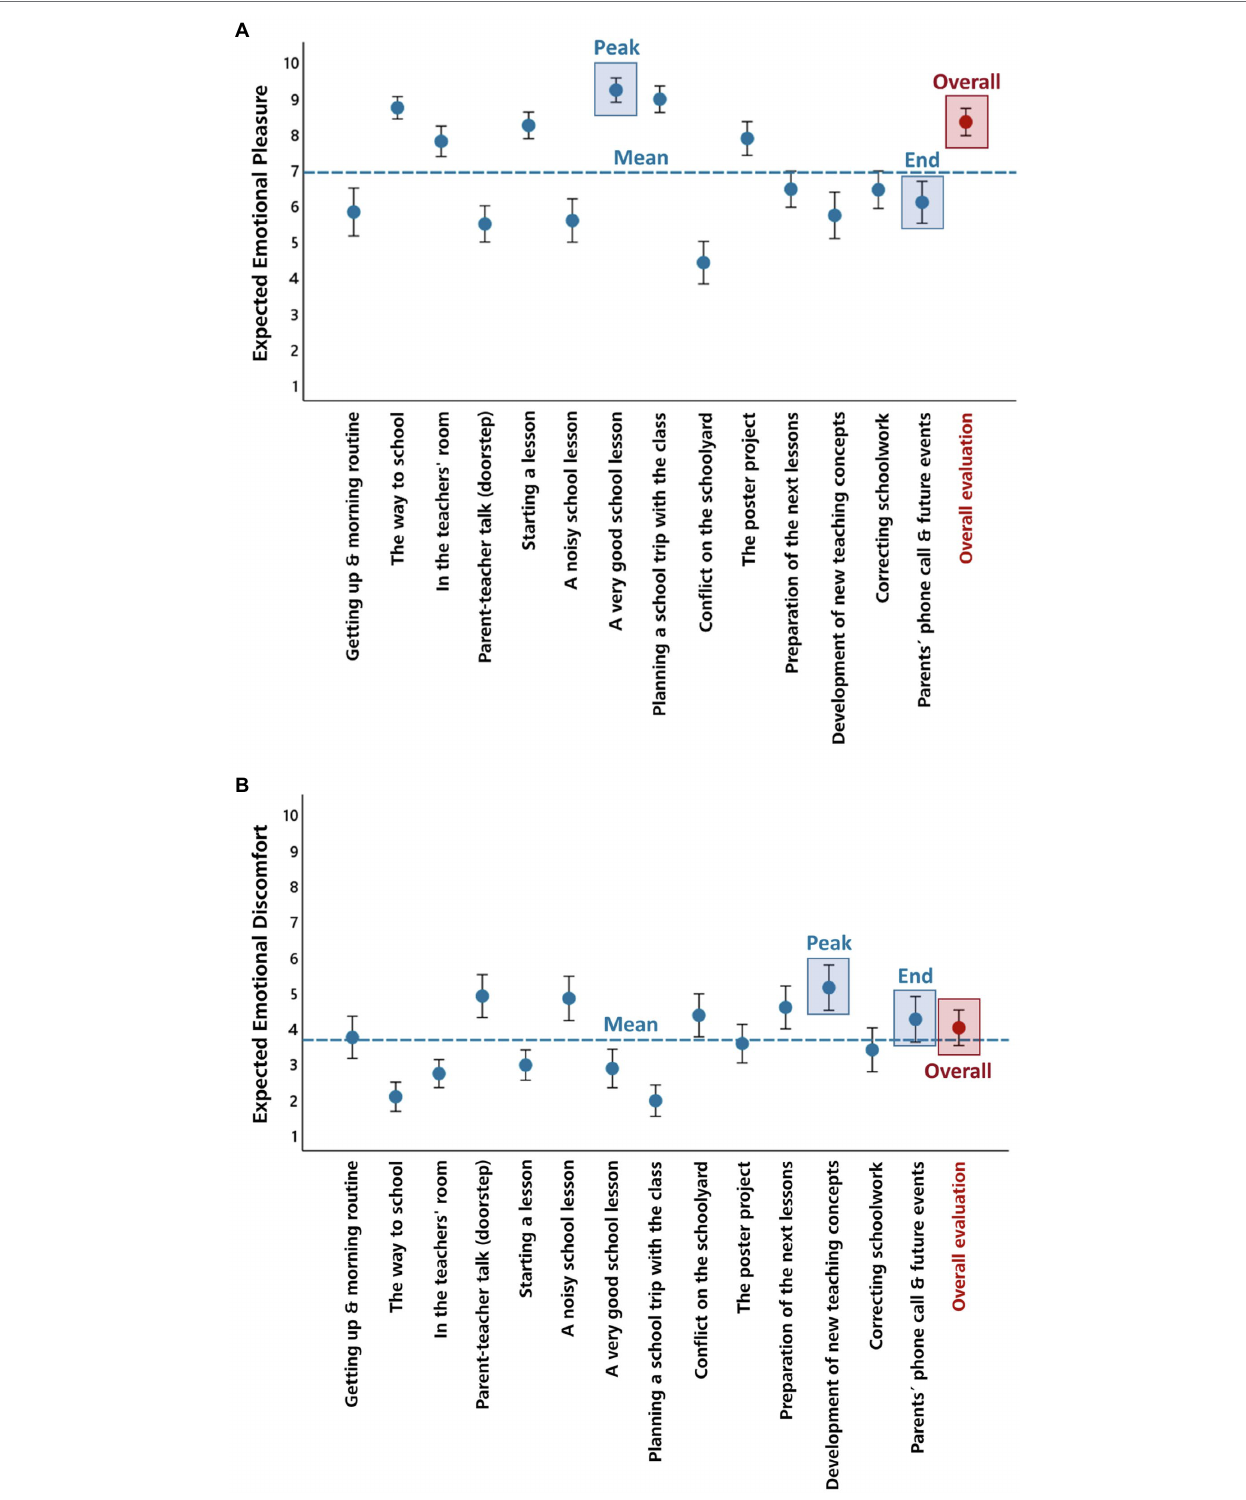
FIGURE 2 | Affective ratings. The mean expected emotional pleasure (A) and mean expected emotional discomfort (B) for each of the 14 evaluated teaching- related events (blue colors) and for the future professional life as a teacher as whole (red color) are shown. The dashed horizontal lines show the average affective experience across events, the underlaid squares show the event with the peak expected affect and the event evaluated at the end of the sequence. Error bars represent 95%